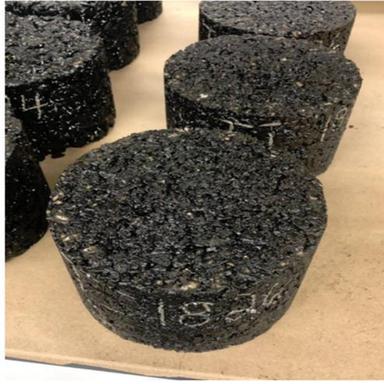
Asphalt mixture samples in MAPIL. Fig. 29. The 3D printed mold used for scanning asphalt mixture samples.